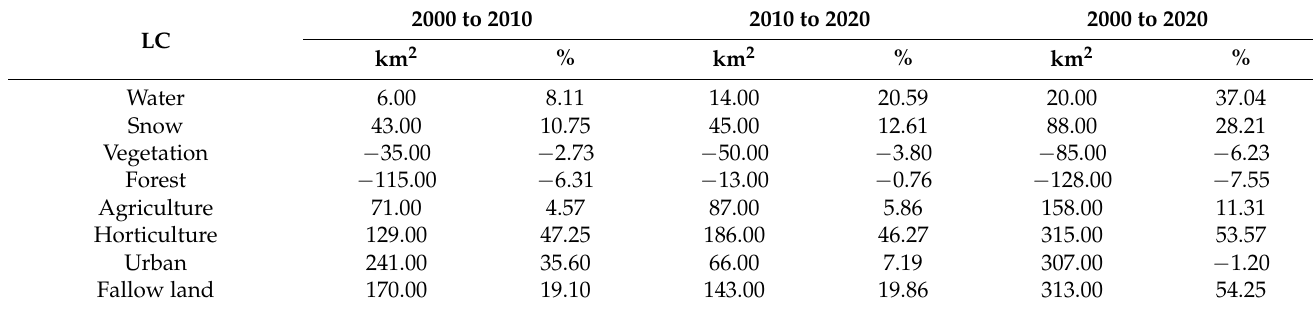
Table 4. Area changes in each LC type from 2000 to 2010, 2010 to 2020, and 2000 to 2020.